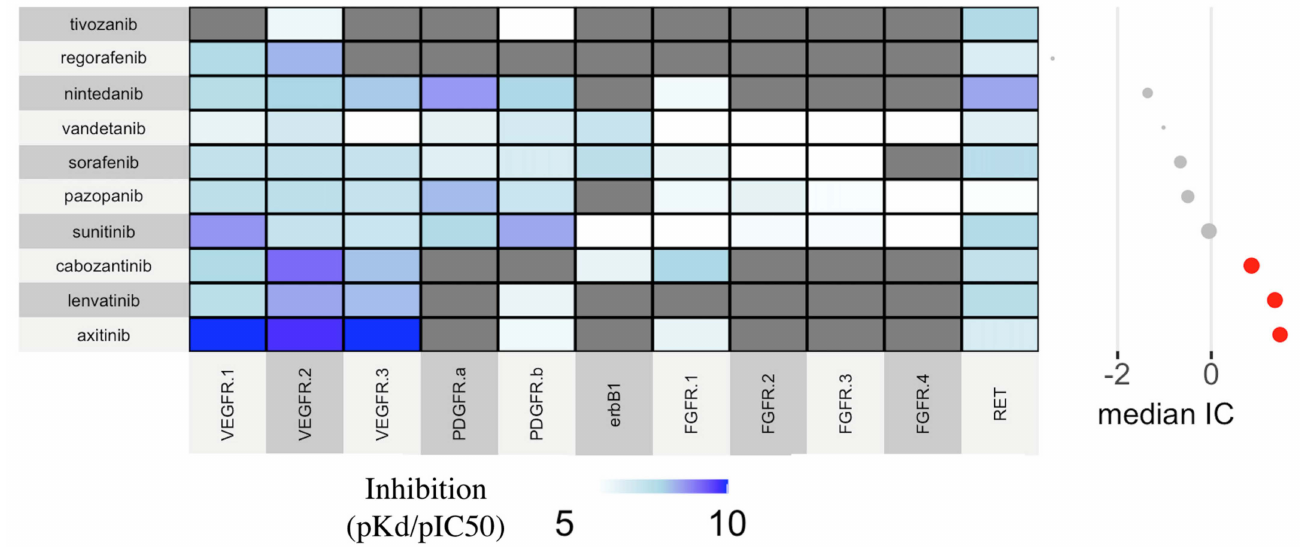
Figure 3. Heatmap showing the extent of VEGFR-TKIs affinities in relation with disproportion- ality analysis. The intensity of the cold tone (antagonism) is proportional to the receptor affinity (pKd/pIC 50 ). Grey color code indicates missing pharmacodynamic data. The adjacent plot shows significant (in red) and non-significant (in grey) disproportionalities using anticancer drugs as a comparator (information